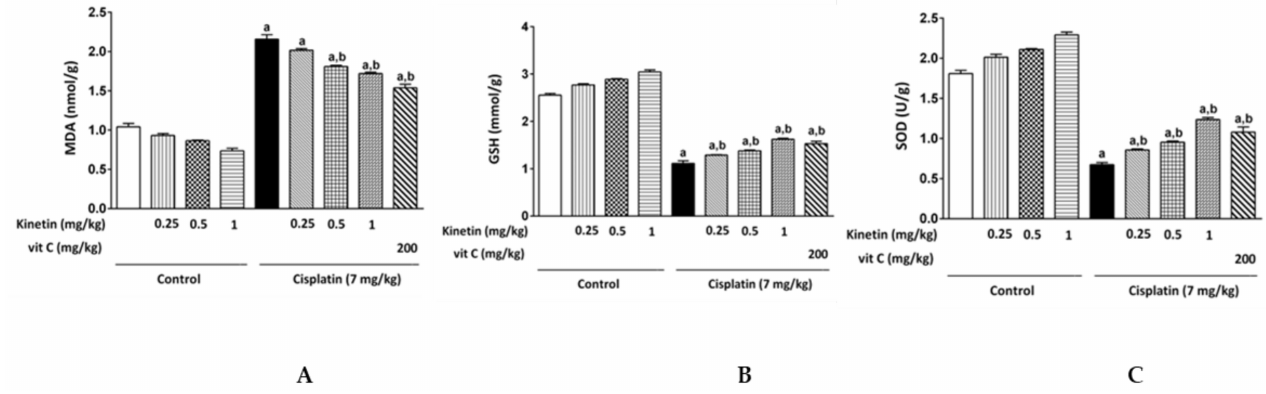
Figure 2. Effect Effect of kinetin oon hepatic redox status. Effect of different doses of kinetin and vitamin C on hepatic ( A ) MDA, ( B ) GSH and ( C ) SOD. a Significantly different from control group, b significantly different from cisplatin group according to one-way ANOVA followed by Tukey–Kramer multiple comparisons test at p < 0.01, ( n = 6). Tests were performed as described in Research Design and Methods. MDA: malondialdehyde, GSH: glutathione, SOD: superoxide dismutase, Vit C: vitamin C.